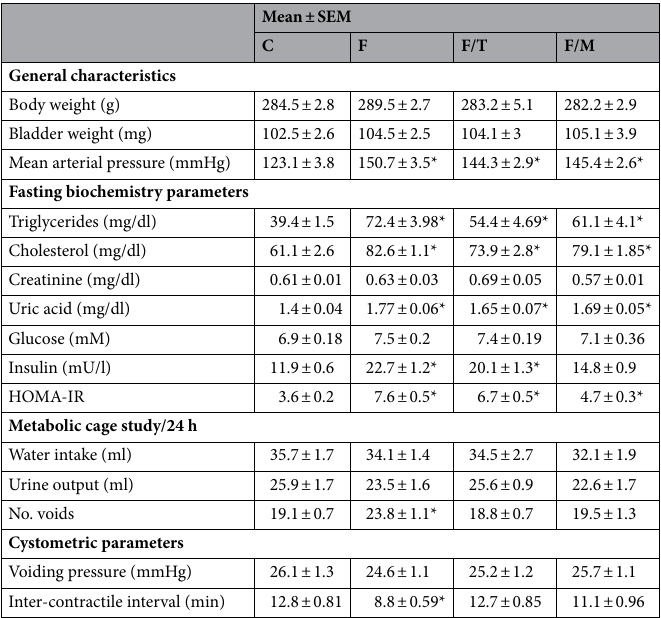
Table 1. General characteristics of experimental animals. Data are presented in mean ± SEM, n = 12 in each group. C, control group; F, fructose fed group; F/T. fructose fed animals with addition of datalafil treatment; F/M fructose fed animals with addition of metformin